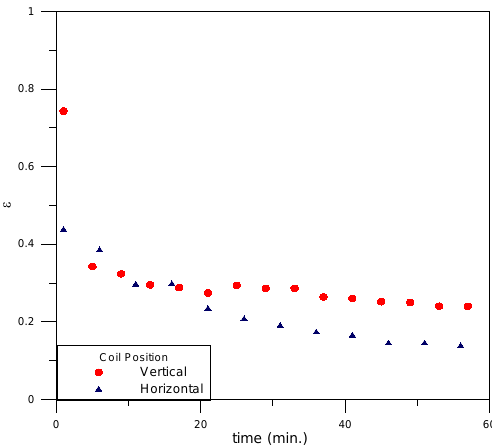
Figure 11. Coil performance for different mass